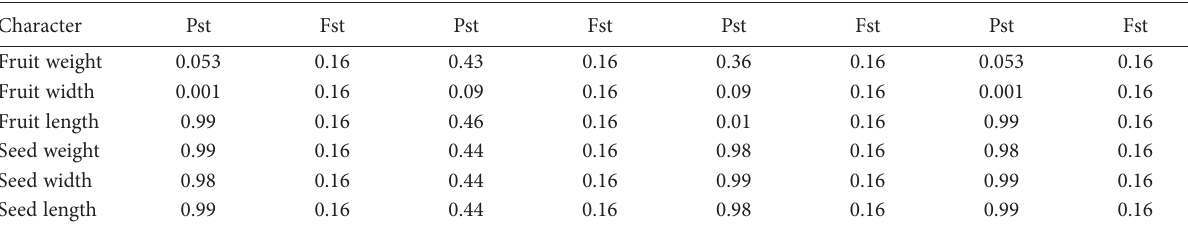
Table S7. Fst versus Pst values in cultivar No.3 with